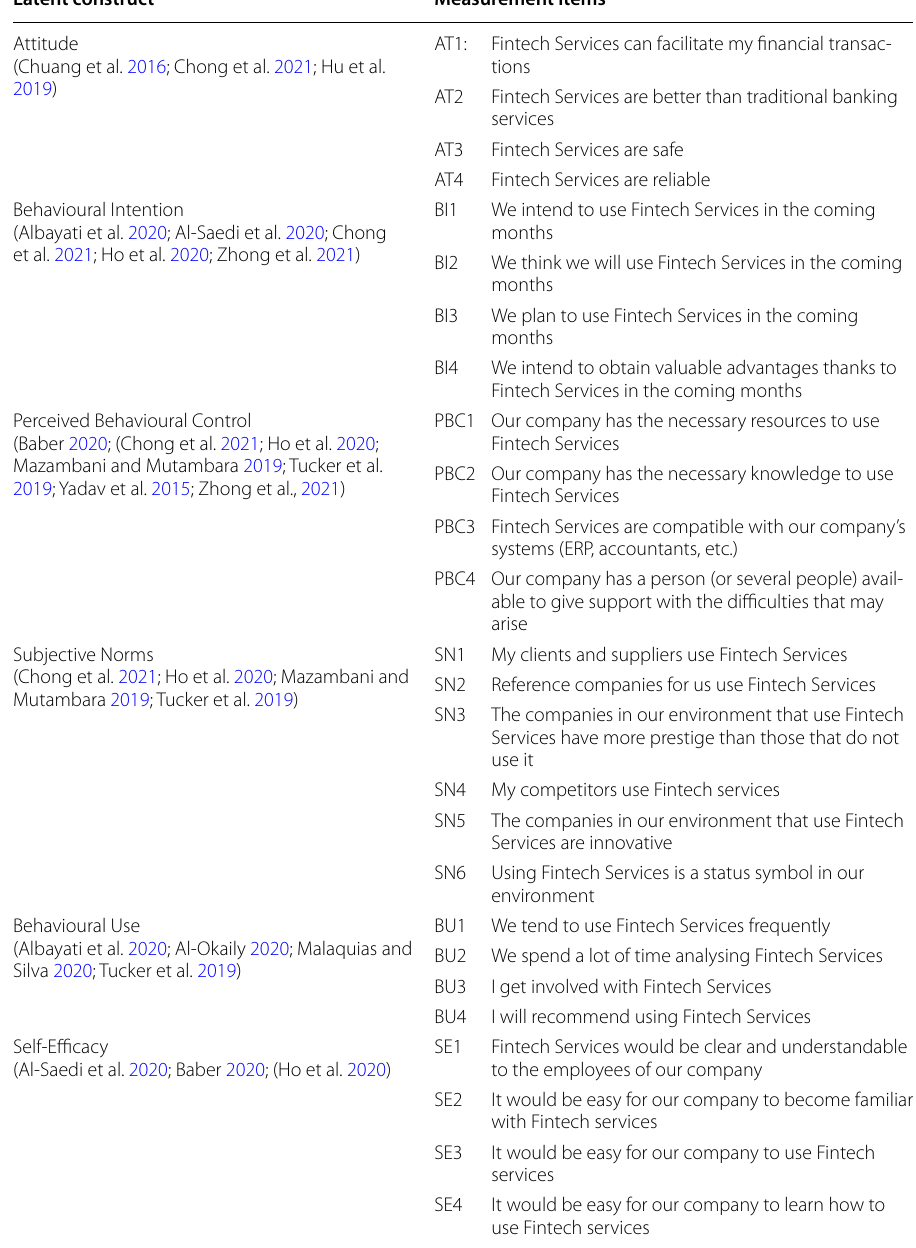
Table 2 Measurement scales Latent